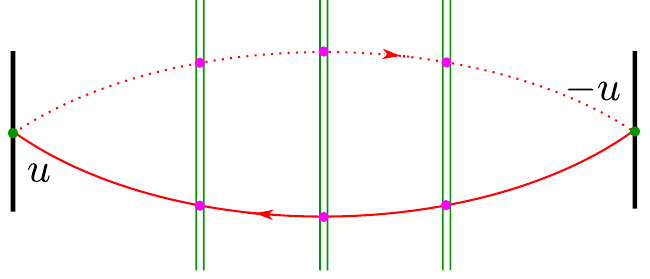
Figure 8. Transfer matrix in fundamental representation for J = 3